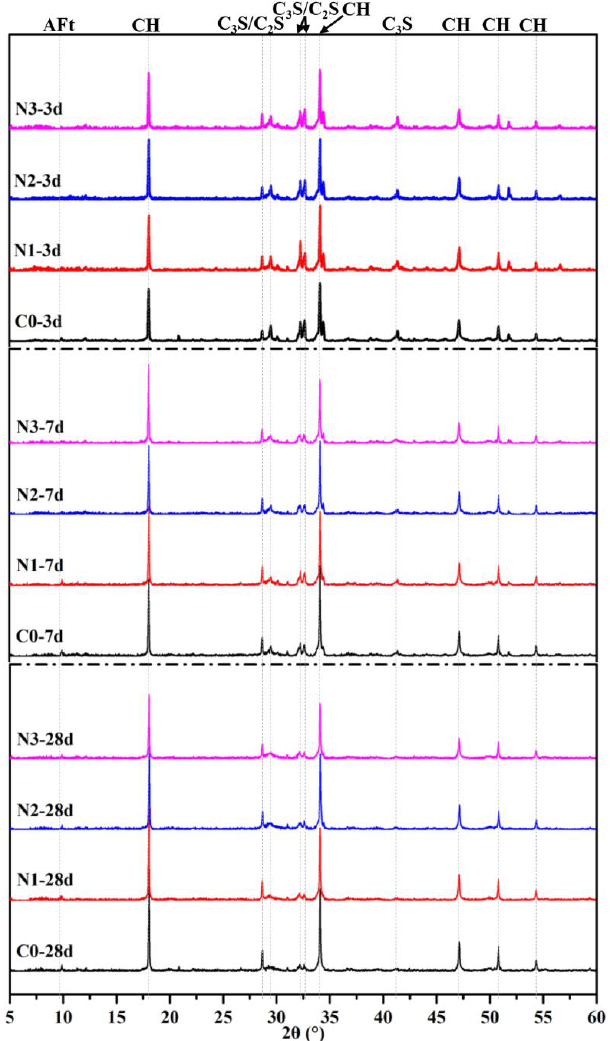
Figure 15. XRD curves of different cement pastes. In order to quantitatively analyze the CH content of samples with or without CNS, DSC-DTG analysis was conducted and the CH content of samples was calculated according to Equation (10) (Figure 16)